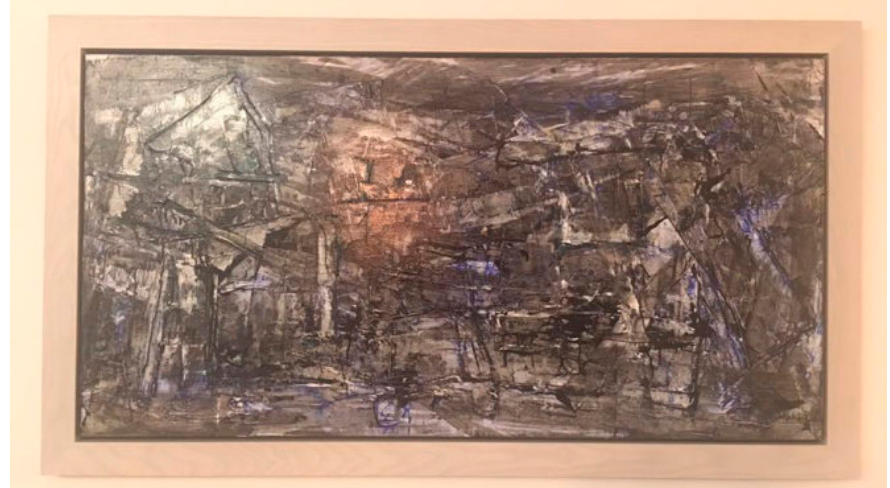
Figure A1. Nguyen Ro Hung’s copied painting with Pham An Hai’s signature 1. The image was sourced from Tuoi Tre Newspaper (Viet 2017).